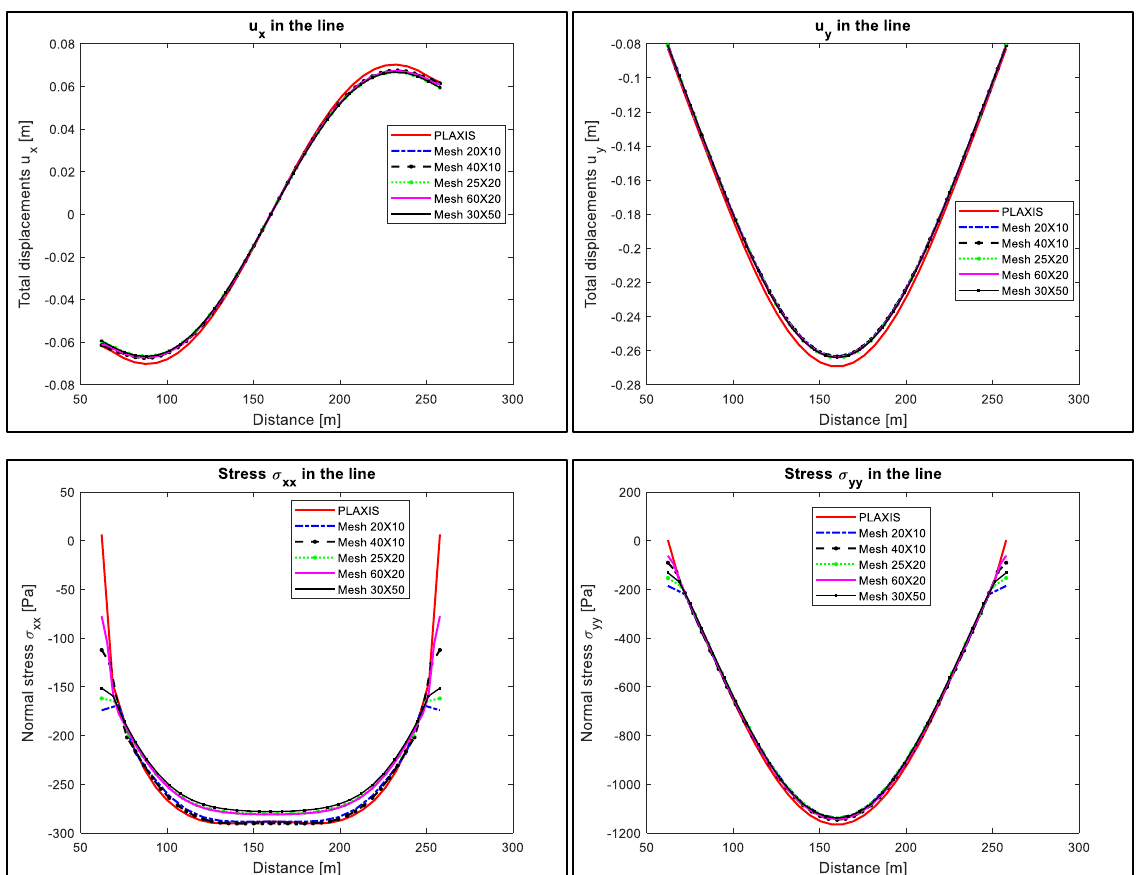
Figure 12. Displacements and stresses in the line considered for Matlab and PLAXIS models according to mesh size.